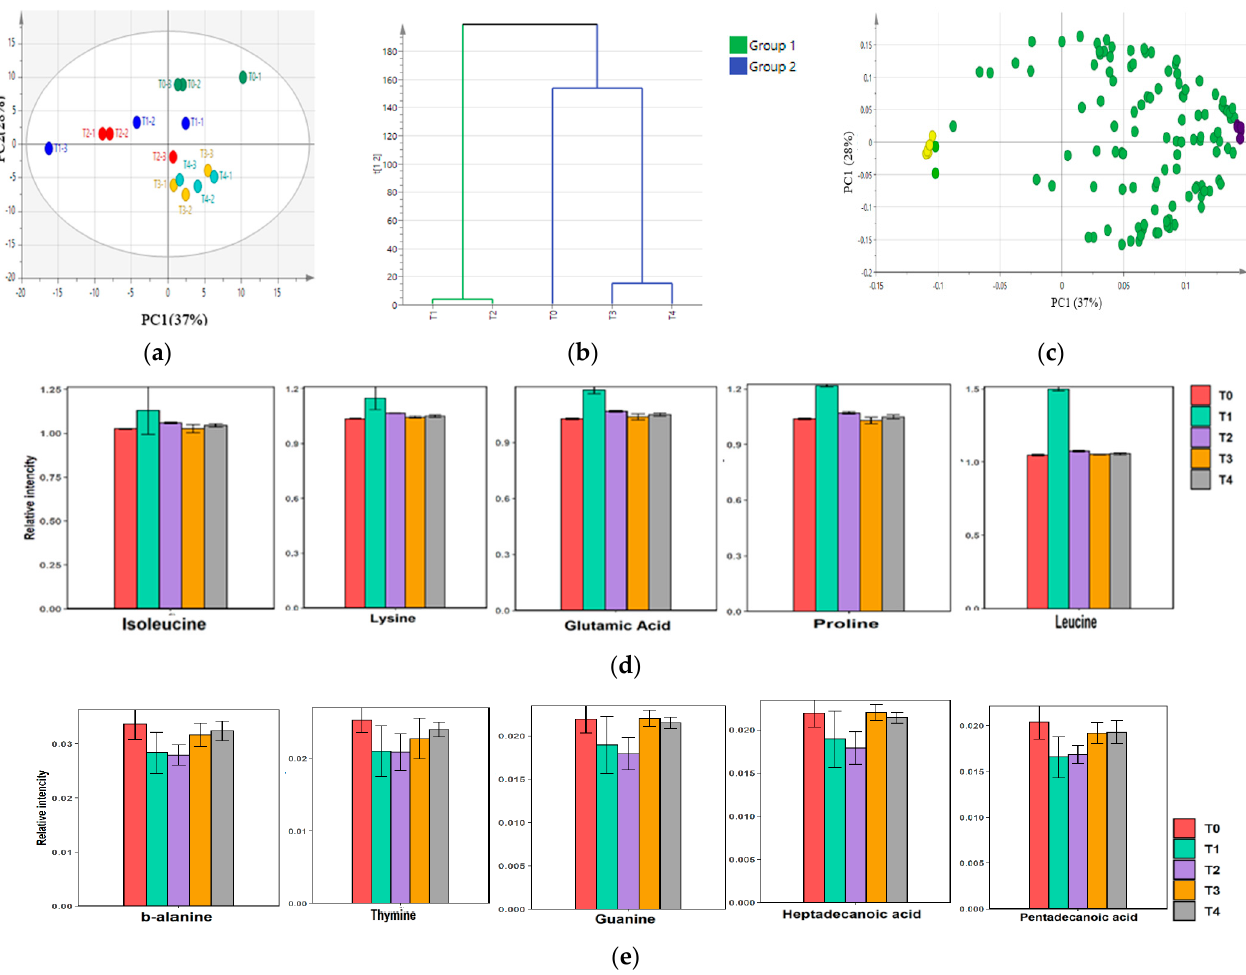
Figure 3. Principle component analysis (PCA) score plot and loading plot of low–salt shrimp paste at different time points during fermentation. Data were acquired from GC/MS analysis of triplicate samples, using ribitol as standard and multivariate analysis, using SIMCA 13.0; ( a ) score plot, ( b ) hierarchical cluster analysis, ( c ) loading plot; yellow dots = marker for T1 and T2; purple dots = marker for T0, T3, and T4. ( d ) Top five scores of eigenvector value metabolites correlated with T1 and T2. ( e ) Five top scores of eigenvector value metabolites correlated with T0, T3, and T4. T1 = 7 days of fermentation, T2 = 14 days of fermentation, T3 = 21 days of fermentation, T4 = 28 days of fermentation.